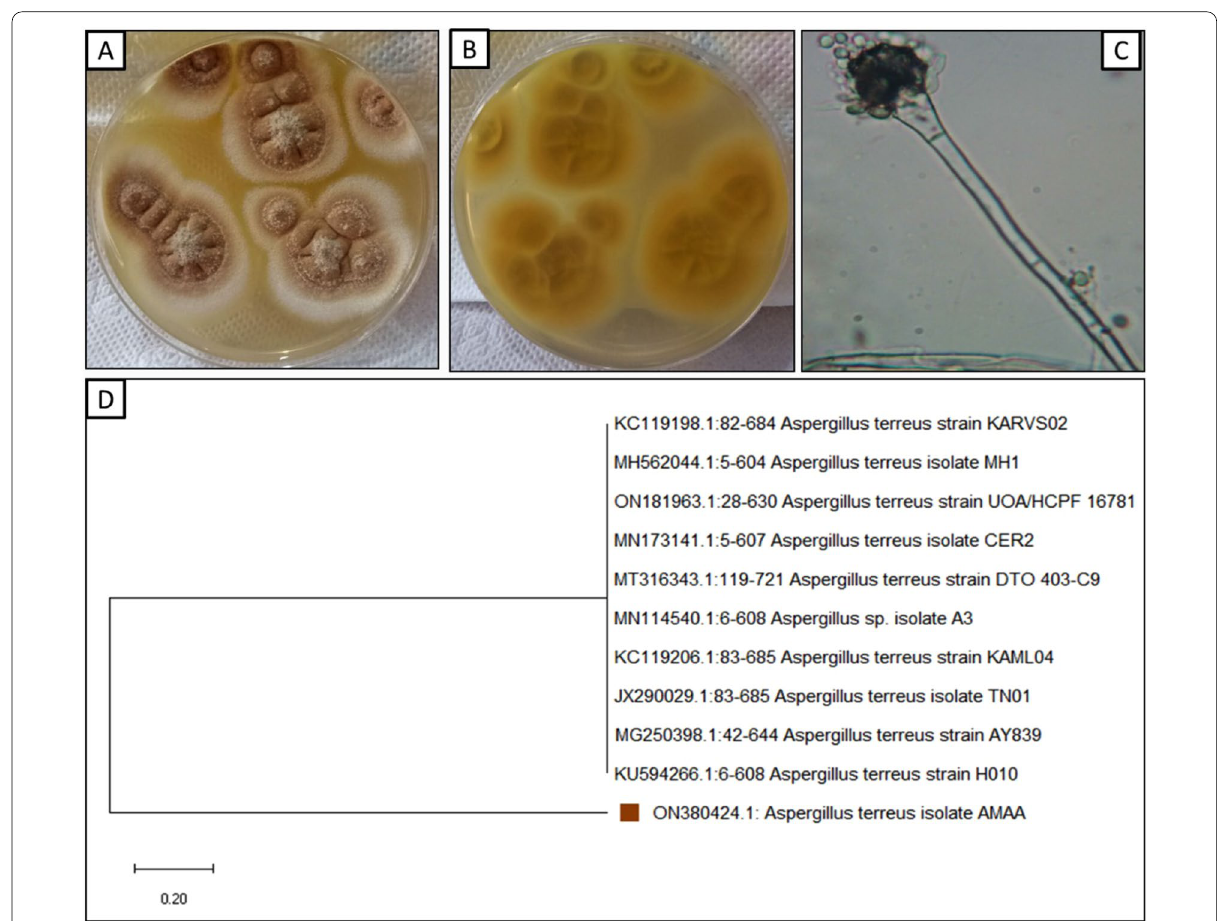
Fig. 1 A - Colony of A. terreus on PDA grown at 28 °C for 4 days showing the culture characteristics; B - Light microscope showing stipe, conidia, strigmata and conidial head of A. fumigatus (400X); C - Phylogenetic tree of A. terreus with accession number